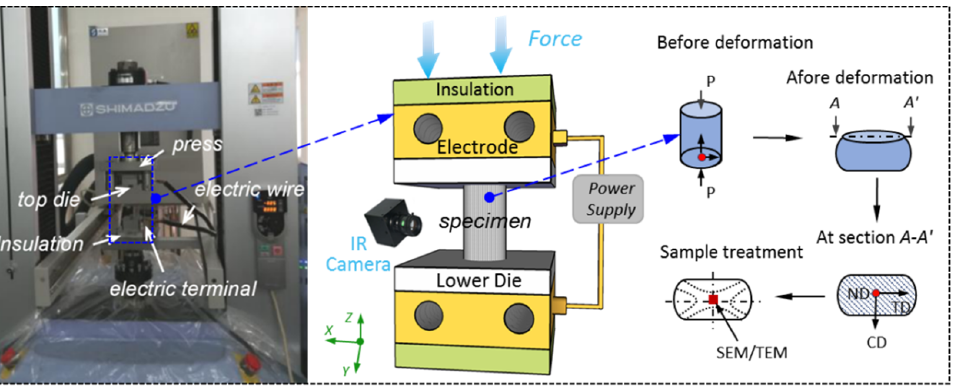
Figure 2. Schematic diagram of the electrically-assisted forming platform and the micro-compres- sion samples at different stages in the experimental process.